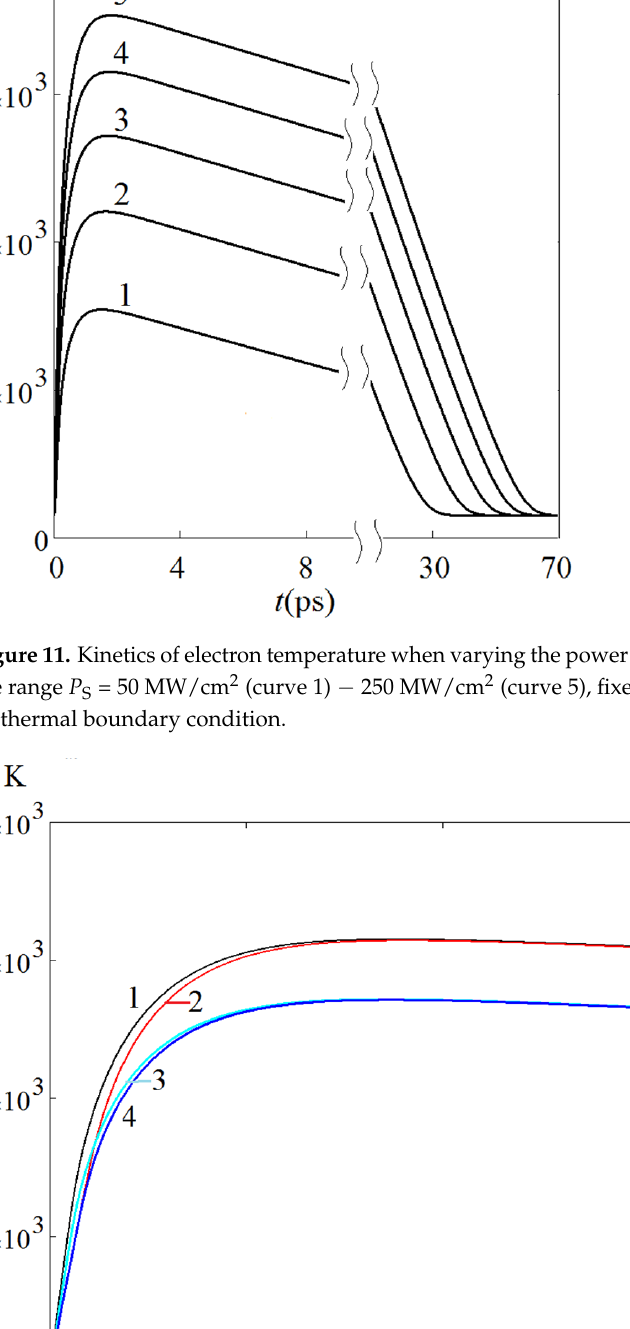
Figure 12. Kinetics of electron temperature for the following parameters: curve 1—power density of irradiating light P S = 200 MW/cm 2 and pulse duration t p = 100 fs; curve 2—100 MW/cm 2 and 200 fs; curve 3—150 MW/cm 2 and 100 fs; curve 4—100 MW/cm 2 and 150 fs, respectively. The calculations correspond to the isothermal boundary condition with the same other parameters.